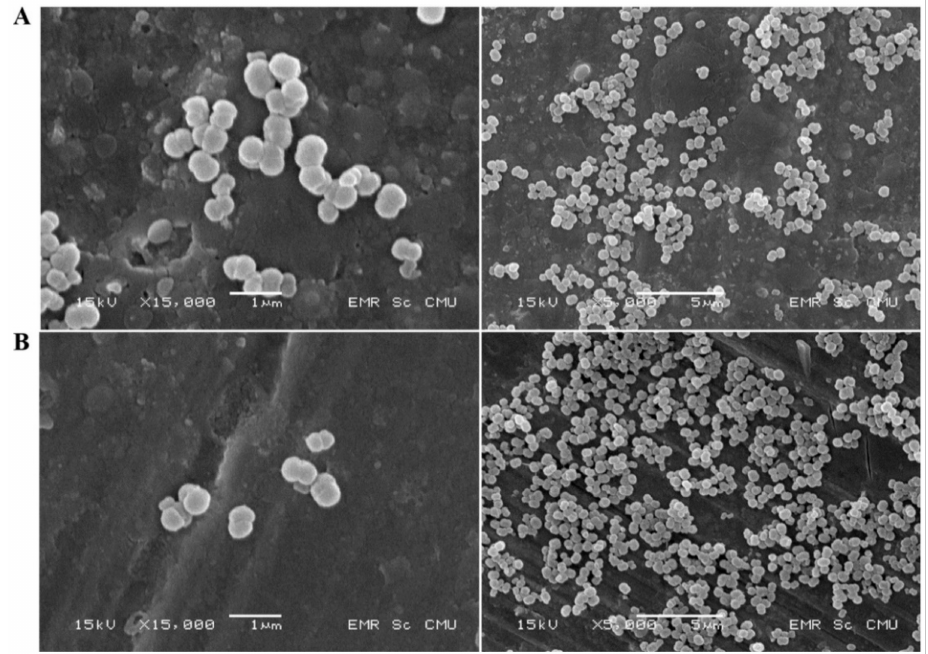
Figure 5. SEM images of non-sericin loaded human serum albumin micro particles, HSA-MP ( A ), and human serum albumin micro particles, NS-HSA-MP ( B